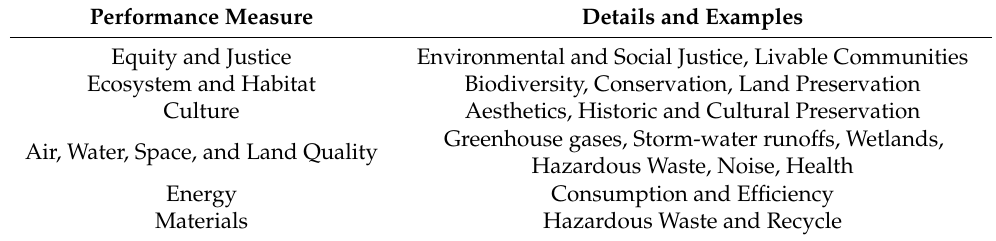
Figure 1. Hierarchy of substantiality measures. Table 1. Sustainability measures.